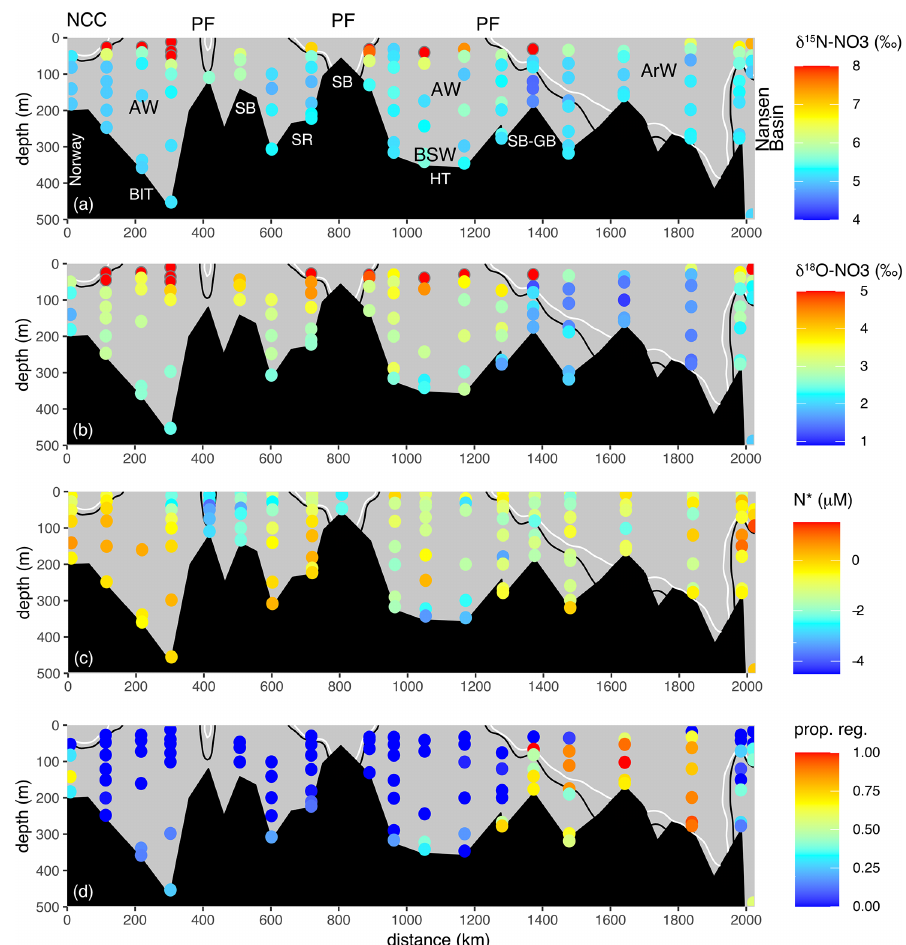
Figure 3. Full 2017 transect of (a) δ 15 N-NO 3 , (b) δ 18 O-NO 3 , (c) N ∗ and (d) proportion of regenerated nitrate. Transect is displayed in Figure 1. Solid black and white lines are the 34.8 and 34.7 isohalines. Atlantic Water (AW), Arctic Water (ArW), Barents Sea Water (BSW) and the Norwegian Coastal Current (NCC) are indicated in (a) . The proportion of regenerated nitrate is predicted using δ 18 O-NO 3 source values from the Atlantic (2.8‰) and a nitrified value calculated using a δ 18 O-H 2 O of 0.2‰ (Schlitzer et al., 2018) plus 1.1‰ (1.3‰). Circles with a grey outline show values not plotted to colour scale and outside of the range used in the